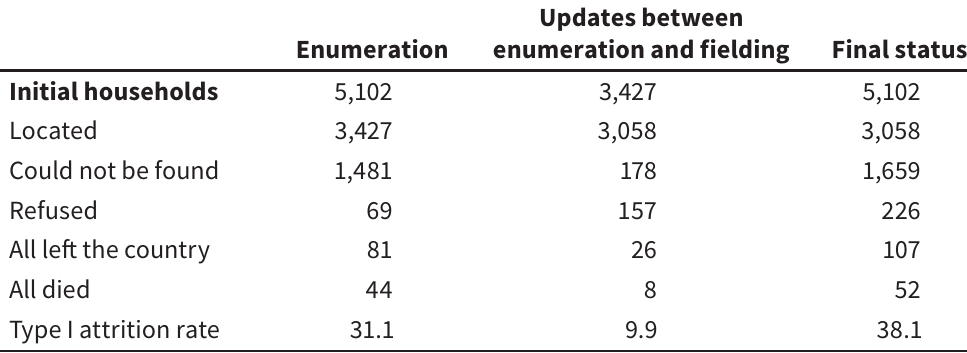
Type I attrition rate 31.1 9.9